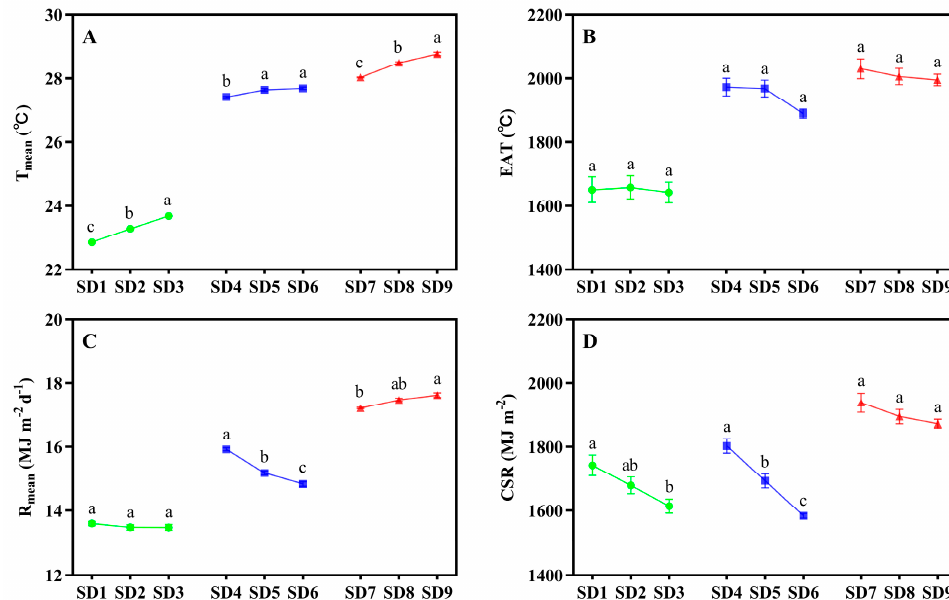
Figure 2. Differences in the average daily temperature ( T mean ) ( A ) and solar radiation ( R mean ) ( B ), effective accumulated temperature (EAT) ( C ) and cumulative solar radiation (CSR) ( D ) of the twelve indica rice cultivars on the three sowing dates of each year during the determined growth durations. SD1, 11 April 2015; SD2, 20 April 2015; SD3, 28 April 2015; SD4, 8 May 2017; SD5, 23 May imply the same below as well. Vertical bars indicate standard errors ( ± ), n = 12 for each SD. Different lowercase letters on the bars of the three SDs in each year indicate significant differences determined by the Tukey test at 5% probability level.